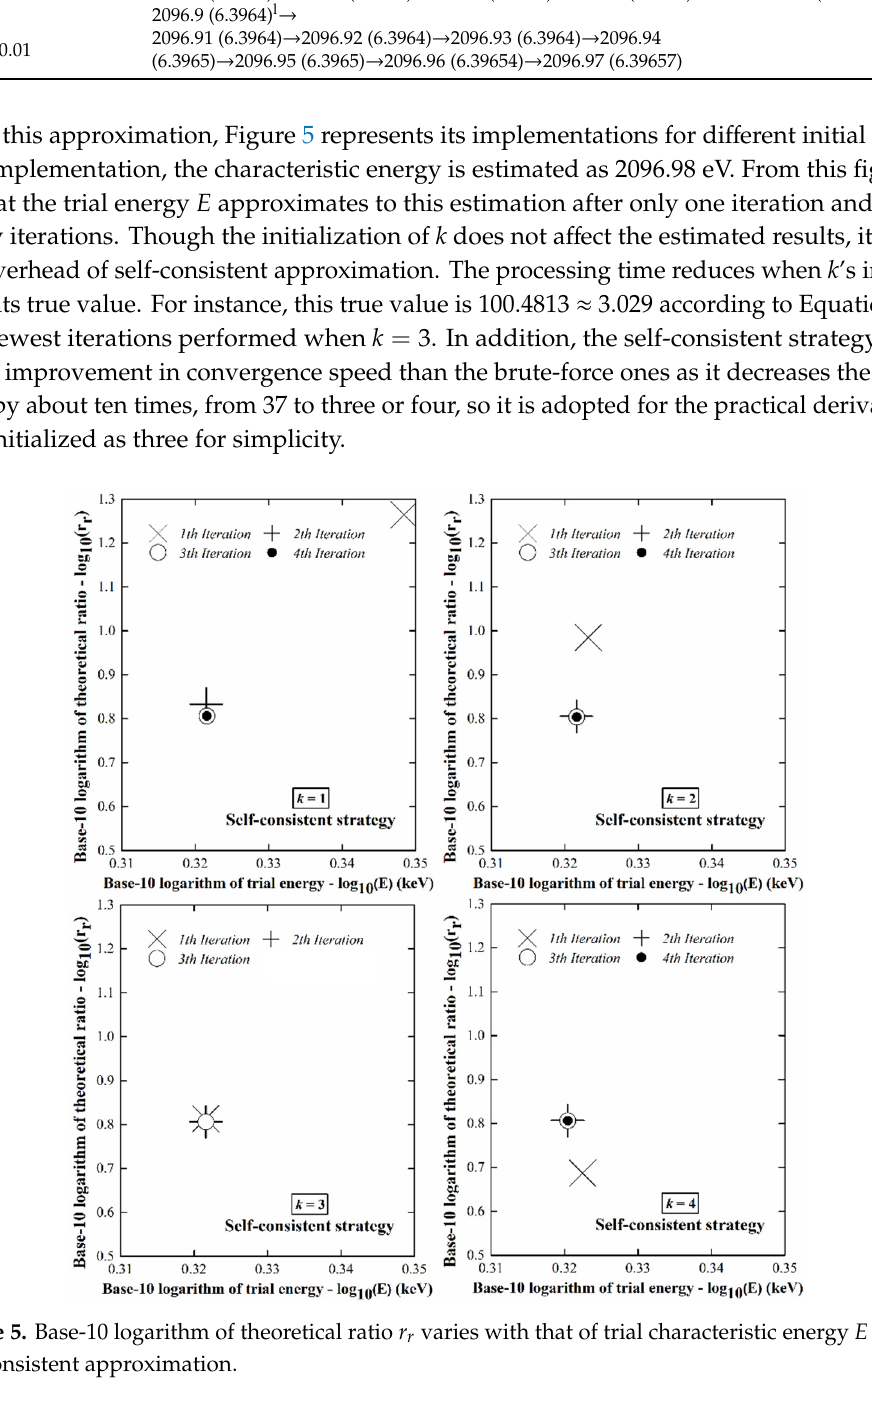
Table 3. Iterative variation of the incremental step dE and incremental interval ( E l , E r ) of trial energy in the recursive brute-force derivation regarding Figure 2.